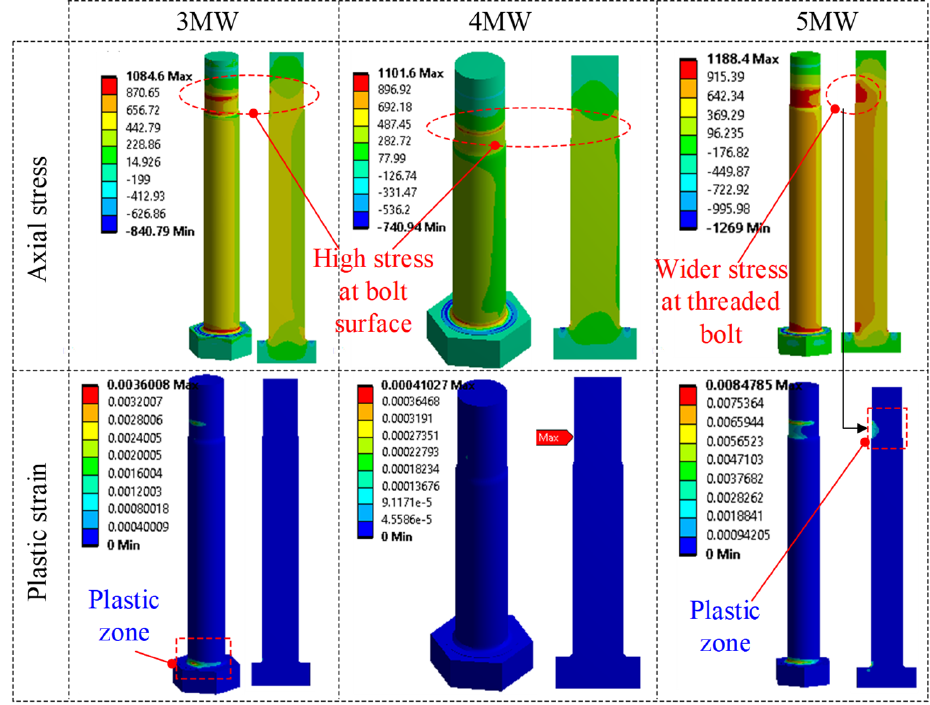
Figure 6. Axial stress and plastic strain in the bolt.